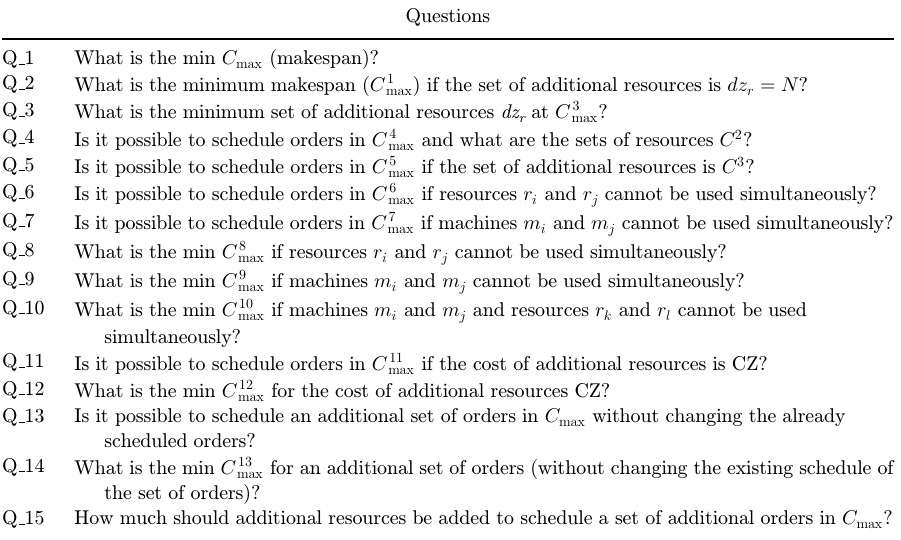
Table 2. Criteria of evaluation and feasibility for schedules in the form of questions.